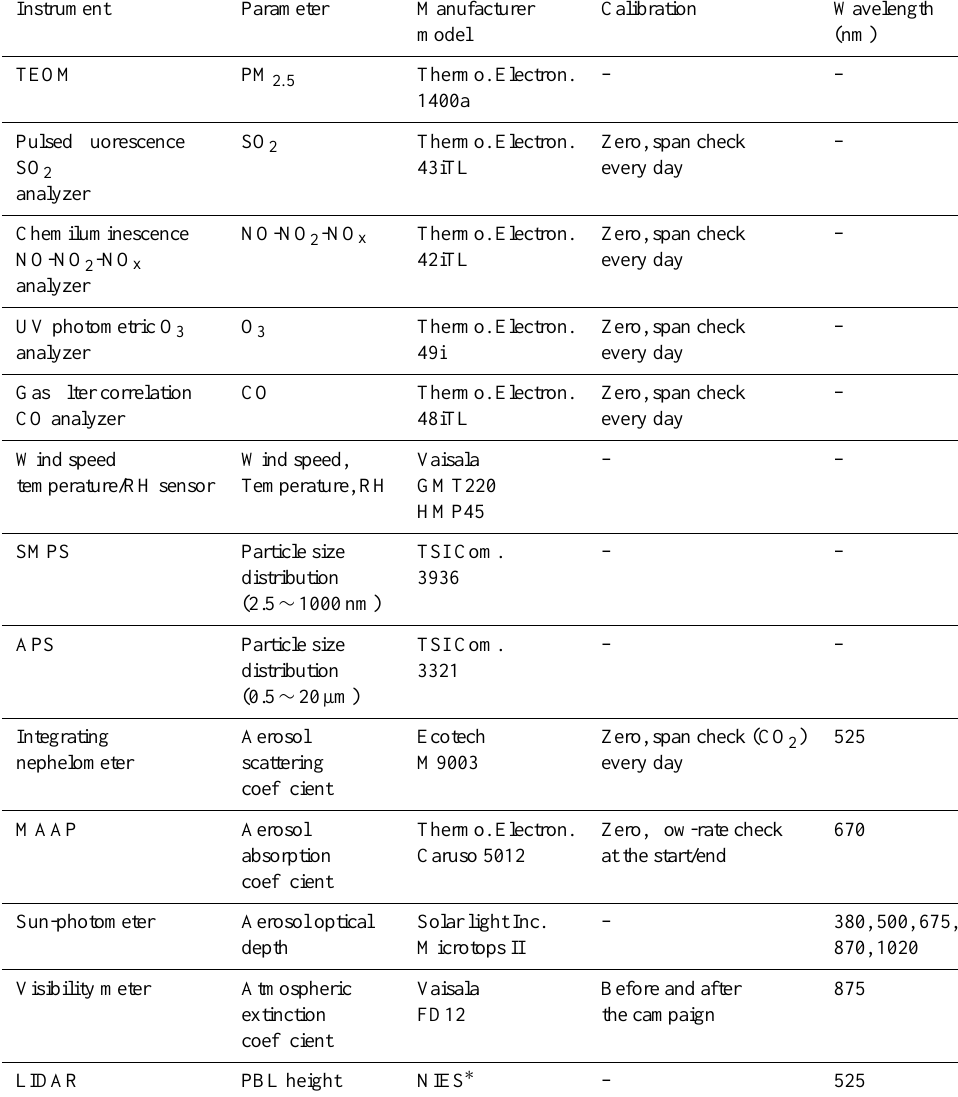
Table 1. Overview of instruments involved in this